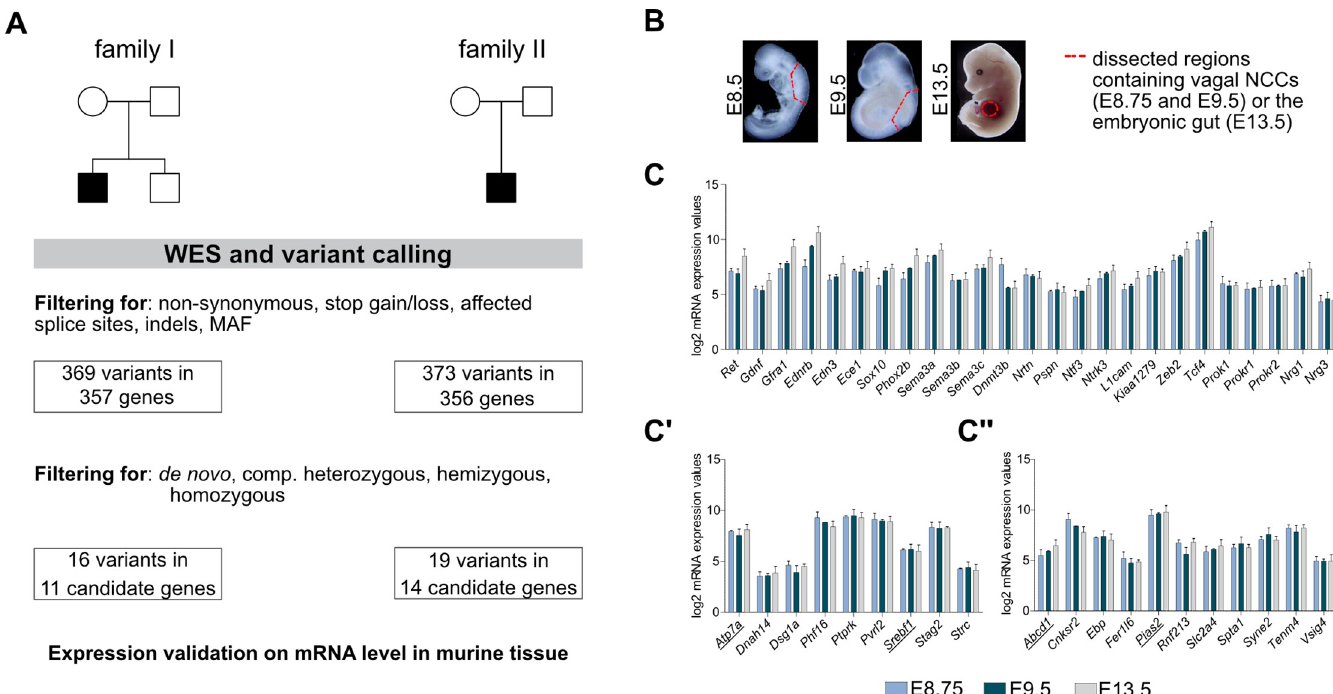
Fig 1. WES data and microarray analysis. (A) Whole exome sequencing (WES) of two sporadic L-HSCR cases in a trio design was followed by variant calling to identify putative HSCR candidate genes. After filtering for respective mutation types, 11 candidate genes remained for patient I and 14 for patient II. (B) For expression validation of filtered candidate genes, transcriptional profiles of relevant embryonic murine tissues were assessed by microarray analysis: vagal NCCs at E8.75/E9.5, embryonic gut at E13.5. (C, C ' , C") Microarray analyses of embryonic murine tissue showing mRNA expression values of known HSCR risk genes (C), and candidate gene homologs of patient I (C ' ) and patient II (C") (selected candidates for follow-up analyses are underscored) (C, C ' , C": n = 3, mean + standard error of mean (SEM)). Fig 1B modified from: https://www.hhmi.org/content/zhang-yi-research-abstract-slideshow. MAF: minor allele frequency, NCC: neural crest cell.